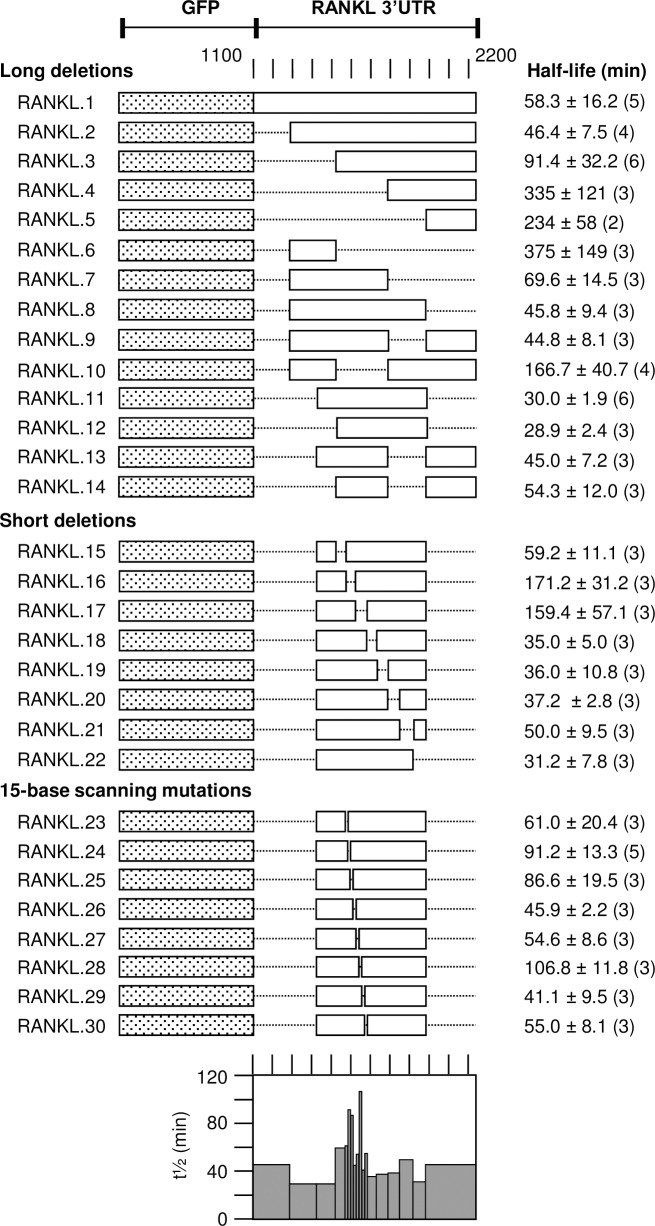
Identification of instability elements in RANKL mRNA.The 3’UTR of the mouse RANKL sequence 1106–2235 (NM_011613.3) with its own natural polyadenylation signal was amplified and inserted into pZPCTHI and transfected stably together with pBHTTA into NIH/3T3 cells. The EGFP-RANKL mRNA half-life was determined by inhibition of the transcriptional transactivator, measuring the mRNA level at 8, 68 and 128 min after doxycycline addition in independently transfected cell cultures, the number of which is indicated for each construct in parenthesis. The first order decay was calculated by linear regression of semi-logarithmic plots. The graphical representation at the bottom summarizes the half-lives for each construct and the increase of mRNA stability in specific mutants.